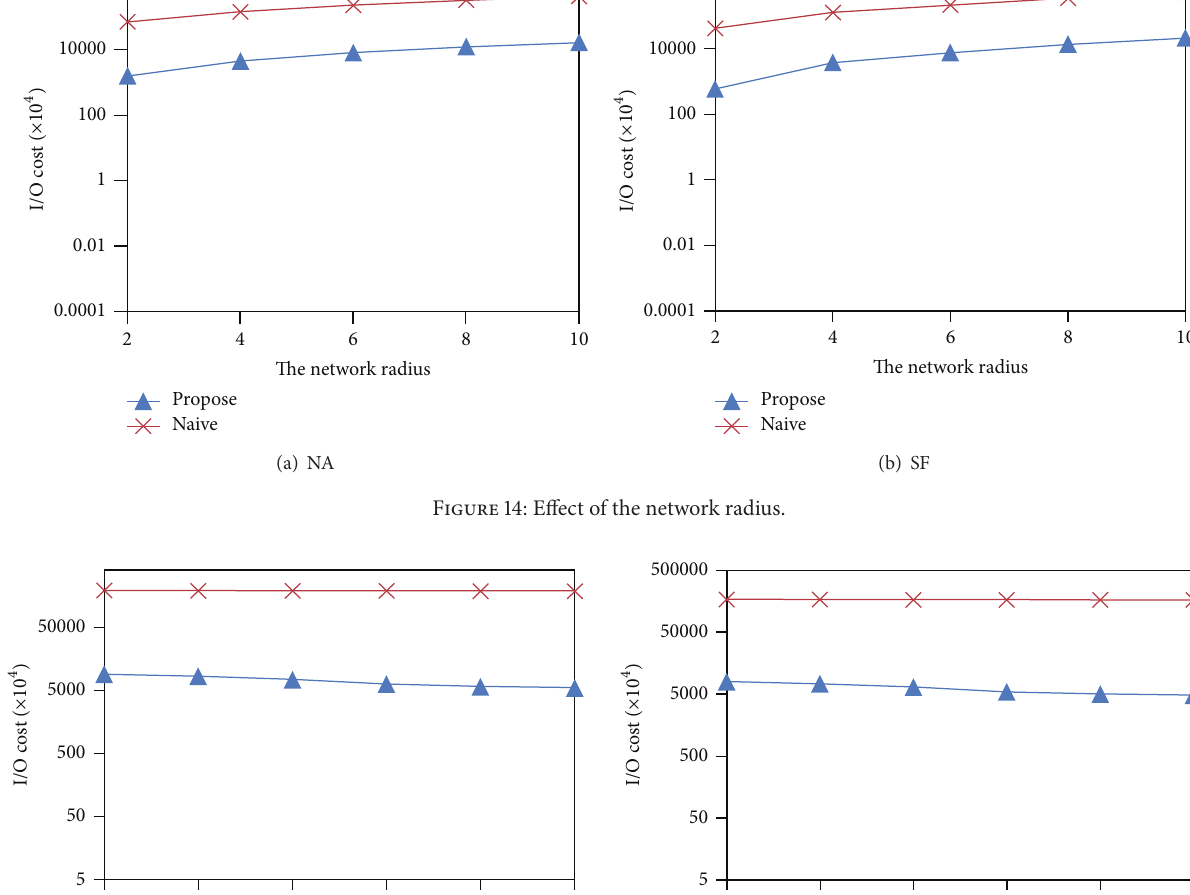
Figure 15: Effect of the buffer size.